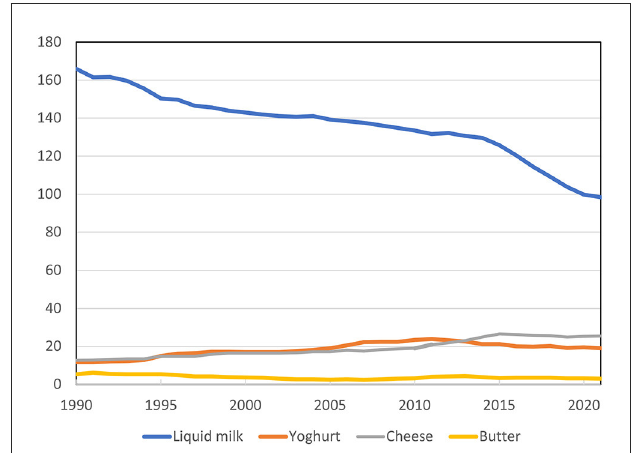
FIGURE1 Consumption of liquid milk, yogurt, cheese, and butter in Finland 1990–2021, kg/per capita. Source: Natural Resources Institute Finland (2022), Balance sheet for food commodities (2021 preliminary data). Fluid milk is the sum of whole milk, low-fat milk, and skim milk consumption.